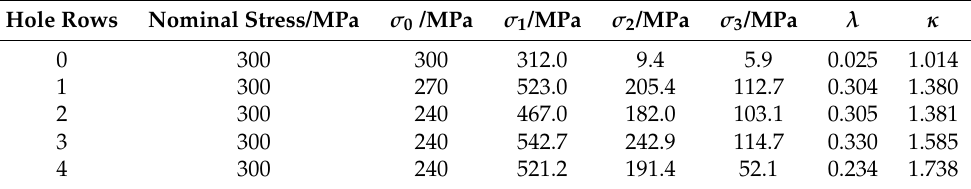
Table 3. Overall stress results of specimen with 0–4 rows of